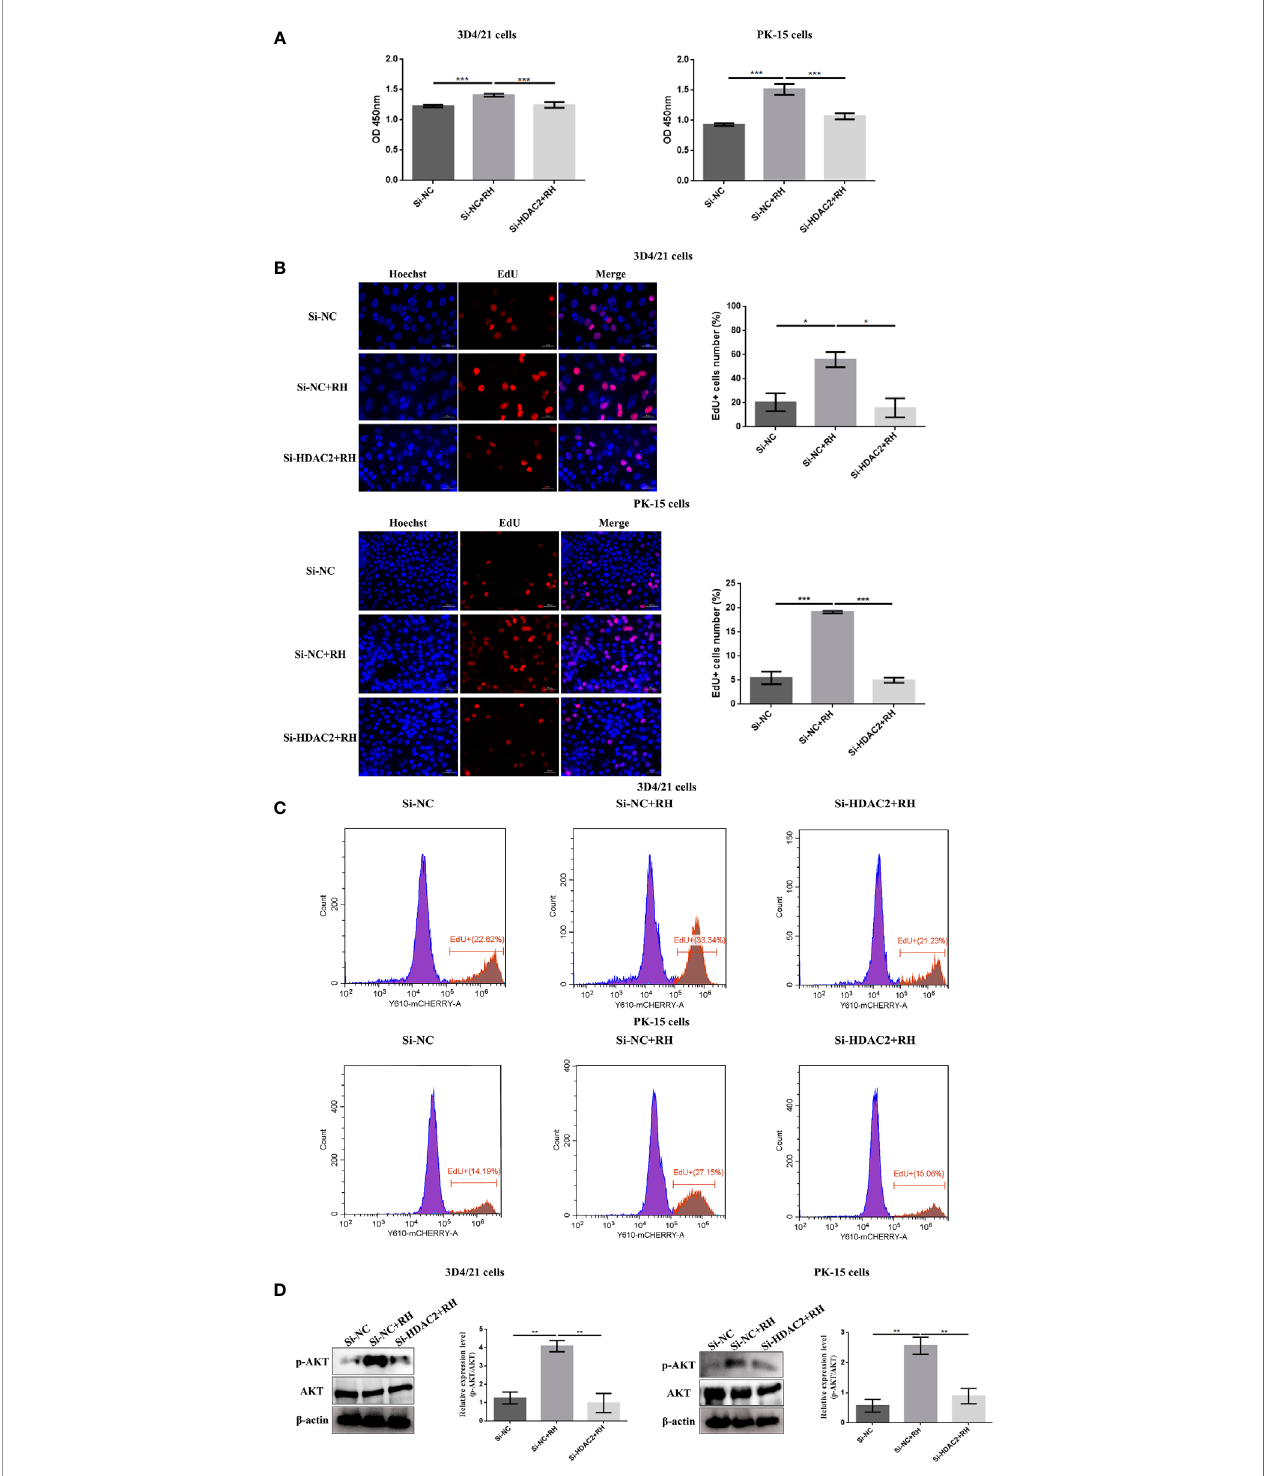
FIGURE 8 | Effects of HDAC2-regulated histone crotonylation on cell proliferation after T. gondii infection. The effect of T. gondii infection on the macrophage proliferation was measured by CCK-8 (A) and EdU (B, C) assays. (D) The expression levels of Akt in 3D4/21 cells and PK-15 cells were measured by Western blotting. The data are presented as the mean ± SEM of three independent experiments. * p < 0.05, ** p < 0.01, *** p < 0.001, one-way